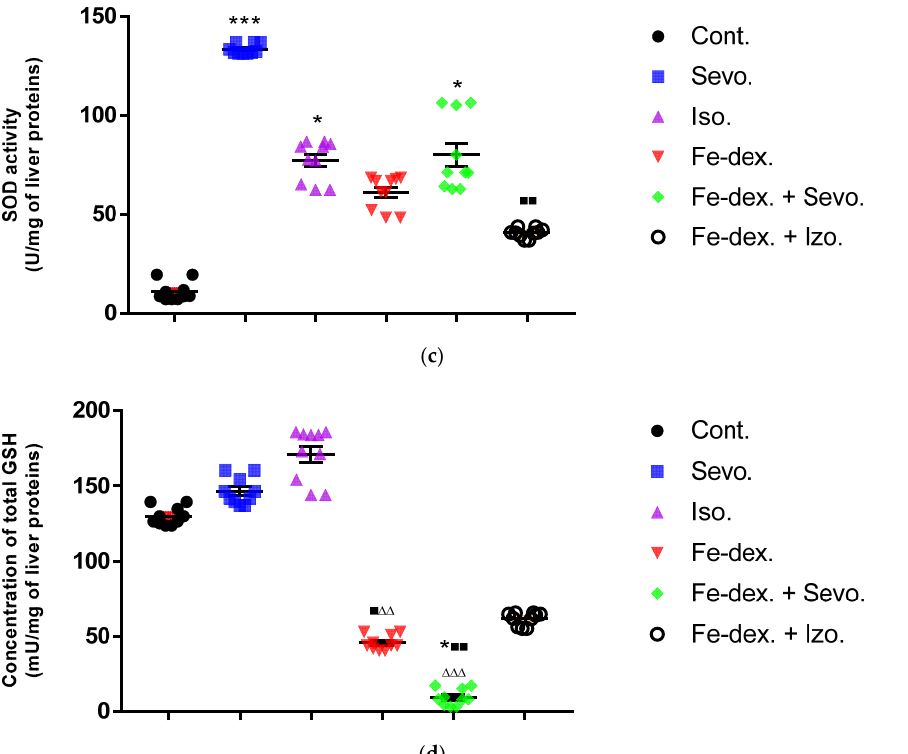
Figure 8. Effect of inhaled anesthetics and iron dextran on MDA ( a ), CAT activity ( b ), SOD activity ( c ), and GSH ( d ) in the liver of rats treated for 28 days. Rats ( n = 10 per group) were treated with ip injection of iron dextran (50 mg/kg), exposed to 2.4 vol % sevoflurane inhalation and 1.3 vol % isoflurane inhalation, and exposed to a combination thereof where inhaled anesthetics were given 2 h after ip injection of iron dextran. Animals were treated every other day for 28 days. Each animal sample is indicated by a single dot. The results are expressed as the mean value of each experimental group ± SE. * Statistically significant compared to the control group (* p < 0.05; ** p < 0.01; *** p < 0.001); ■ Statistically significant compared to the sevoflurane group ( ■ p < 0.05; ■■ p < 0.01); ∆ Statisti- cally significant compared to the isoflurane group ( ∆ p < 0.05; ∆∆ p < 0.01; and ∆∆∆ p < 0.001). Other statistically significant changes exist in: ( b ) catalase activity (U/mg of liver proteins)—Fe-dex. vs. Fe- dex. + Iso. ( p < 0.01); Fe-dex. + Sevo. vs. Fe-dex. + Iso. ( p < 0.05). Abbreviations : Cont., control group; Sevo., sevoflurane group; Iso., isoflurane group; Fe-dex., iron dextran group; Fe-dex. + Sevo., group treated with iron dextran and sevoflurane; and Fe-dex. + Iso., group treated with iron dextran and isoflurane. In the kidney tissue, an increase in MDA and CAT was seen in the group exposed to isoflurane (Figure 9a,b). Furthermore, the level of CAT was increased in the group treated with iron dextran + sevoflurane (by 4.26×; p < 0.01) and iron dextran + isoflurane (by 4.19×; p < 0.05), compared to the the control group (Figure 9b), while in the iron dextran + isoflu- rane treated group the GSH level was decreased compared to the control group ( p < 0.05) (Figure 9d). In the groups treated with sevoflurane and iron dextran, the level of SOD was decreased compared to the group treated with iron dextran + isoflurane ( p < 0.05; p < 0.001 respectively) (Figure 9c), while GSH level was decreased in these groups compared to the control group ( p < 0.01) (Figure 9d).